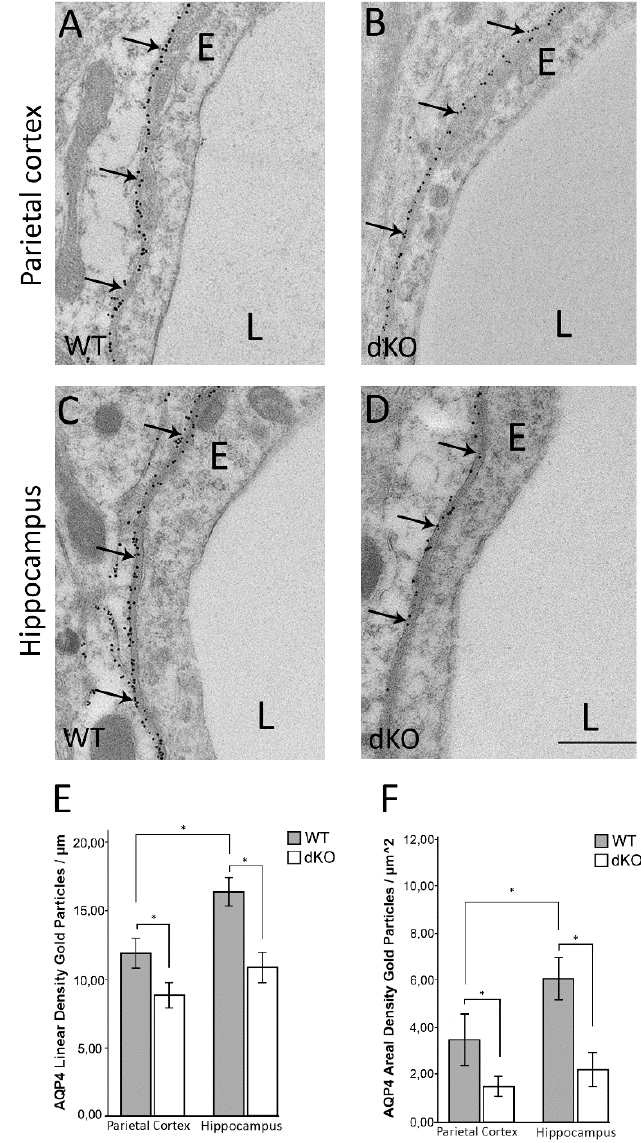
Figure 1. Electron micrographs of parietal cortex and hippocampus of WT and Cx43/30 dKO mice showing AQP4 immunogold labeling. ( A – D ) The AQP4 immunogold labeling is concentrated in the perivascular membrane domain facing endothelium (arrows) (E) Quantitative analysis of perivascular AQP4 immunogold labeling in parietal cortex and hippocampus of Cx43/30 dKO and WT mice. The linear density of gold particles was significantly lower than in WT controls. ( p < 0.001). ( F ) Quantitative analysis of AQP4 immunogold labeling in randomly selected micrographs of neuropil outside the perivascular zone in parietal cortex and hippocampus of Cx43/30 dKO and WT mice. AQP4 labeling intensity was significantly lower in both parietal cortex and hippocampus of Cx43/30 dKO compared to WT ( p < 0.005). E; endothelial cells, L ; vessel lumen. Scale bar: 500 nm. * significant difference according to ANOVA with Bonferroni’s post hoc test; n = 5 for each genotype; error bars indicate SEM. p < 0.05.